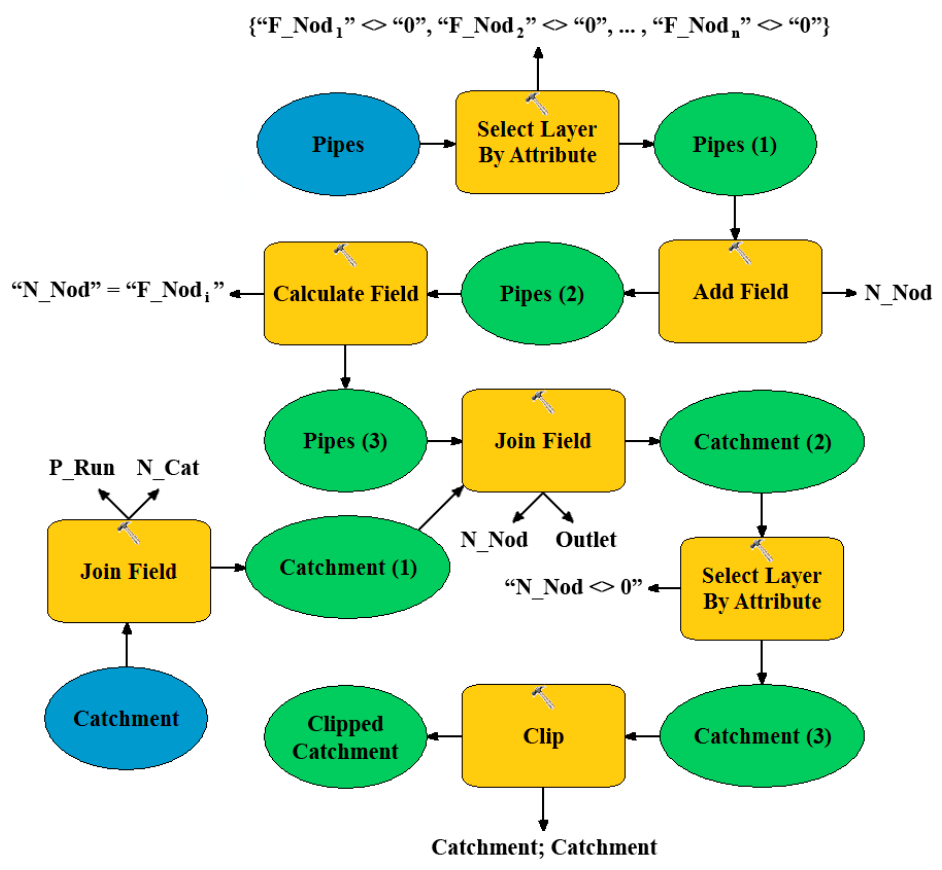
Figure 3. Workflow for the identification of the subcatchments flowing to flood ‐ related nodes.